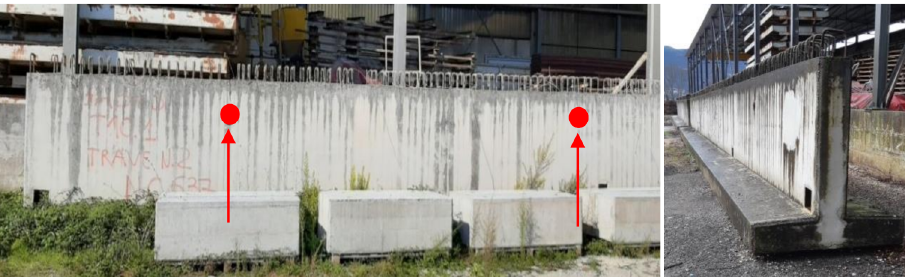
Figure 2. Prestressed RC omega-beam “B1”; red circles show the location of coring sites.